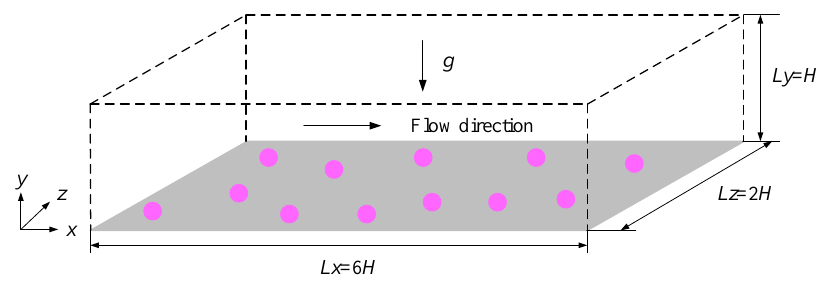
Figure 1. Schematic diagram of the open channel laden with finite-size sediment